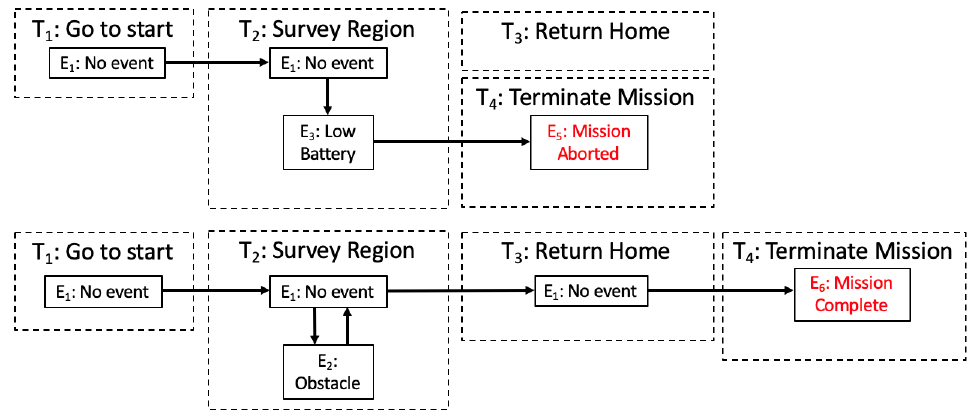
Figure 3. Example of a task and event flow for mission failure ( top ) vs. mission success ( bottom